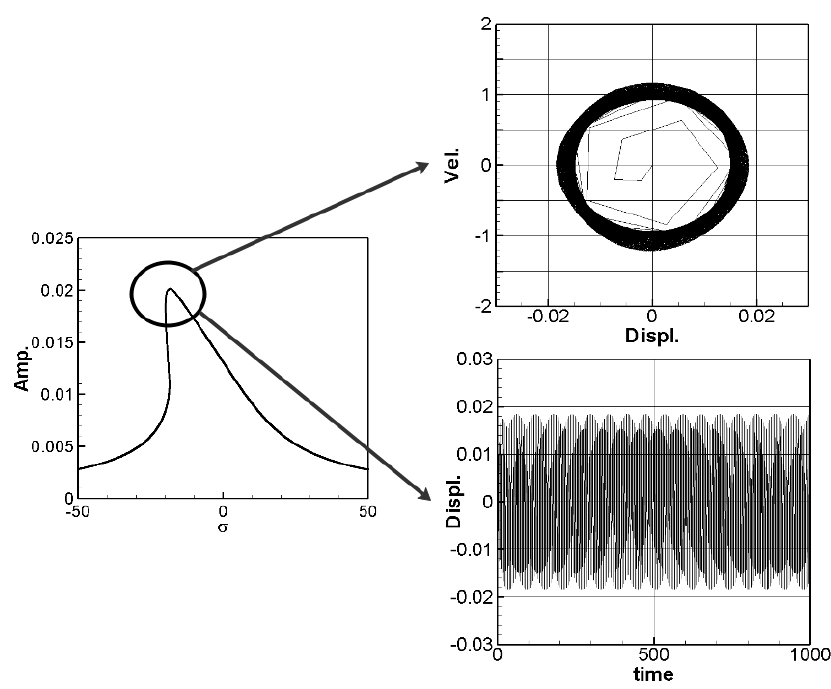
Figure 12. DES verification diagrams of fixed-point plots, phase plots, and time response plots of the 3rd mode’s forced response.